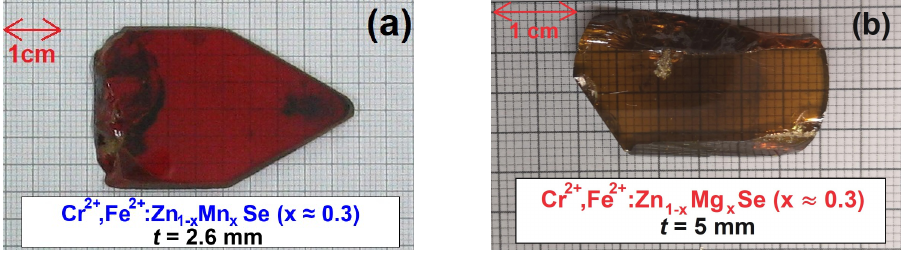
Figure 1. Photos of polished single crystal samples with a 1cm scale. ( a ) Cr,Fe:Zn 1 − x Mn x Se (x ≈ 0.3) crystal. ( b ) Cr,Fe:Zn 1 − x Mg x Se (x ≈ 0.3)